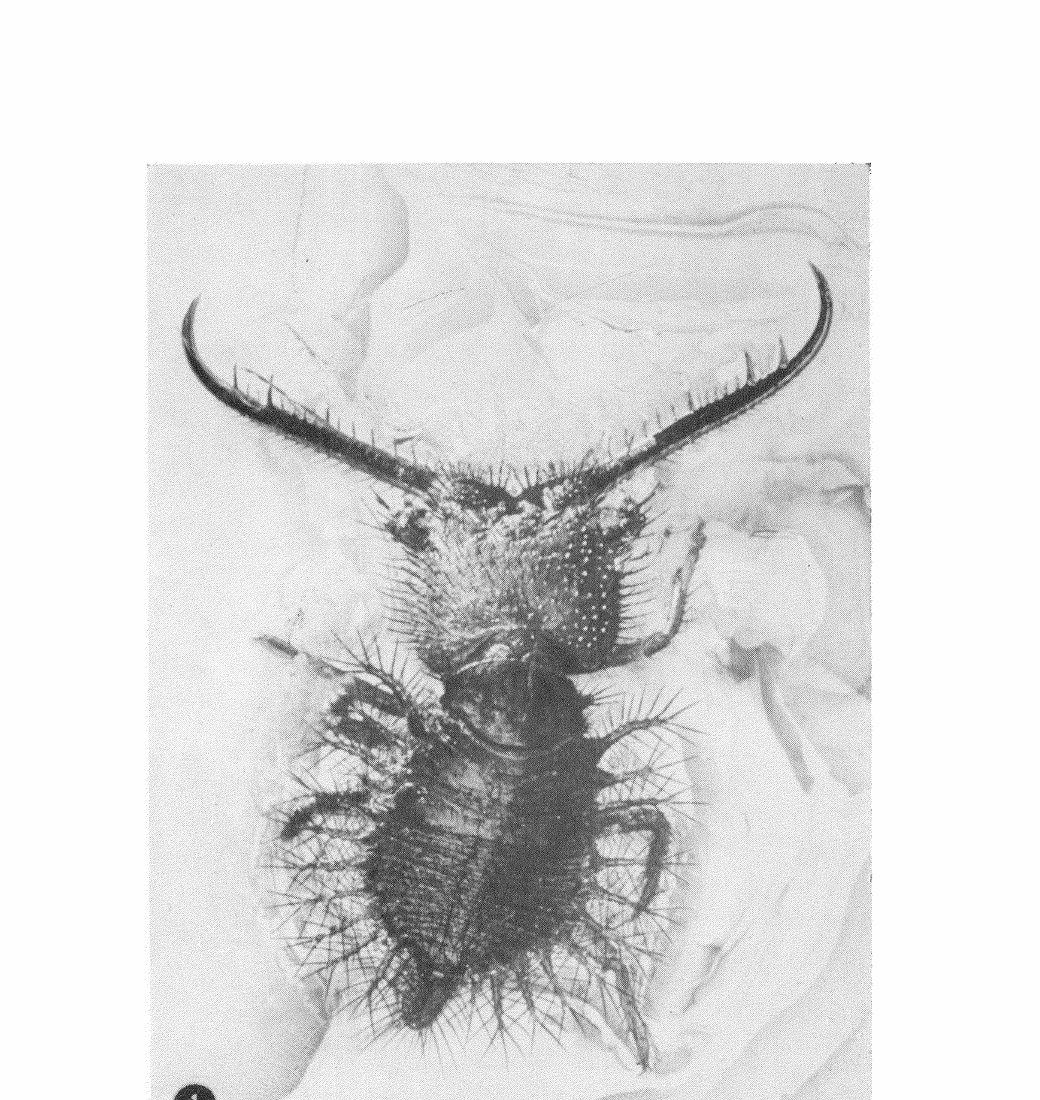
Fig. 1. Neadelhus rotae n. sp. Dorsal aspect ot